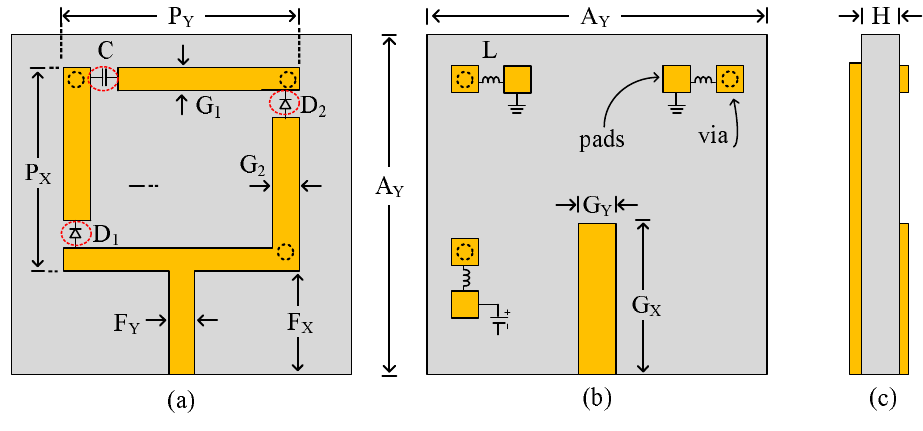
Figure 1. Proposed frequency reconfigurable antenna ( a ) top-view ( b ) bottom-view ( c )